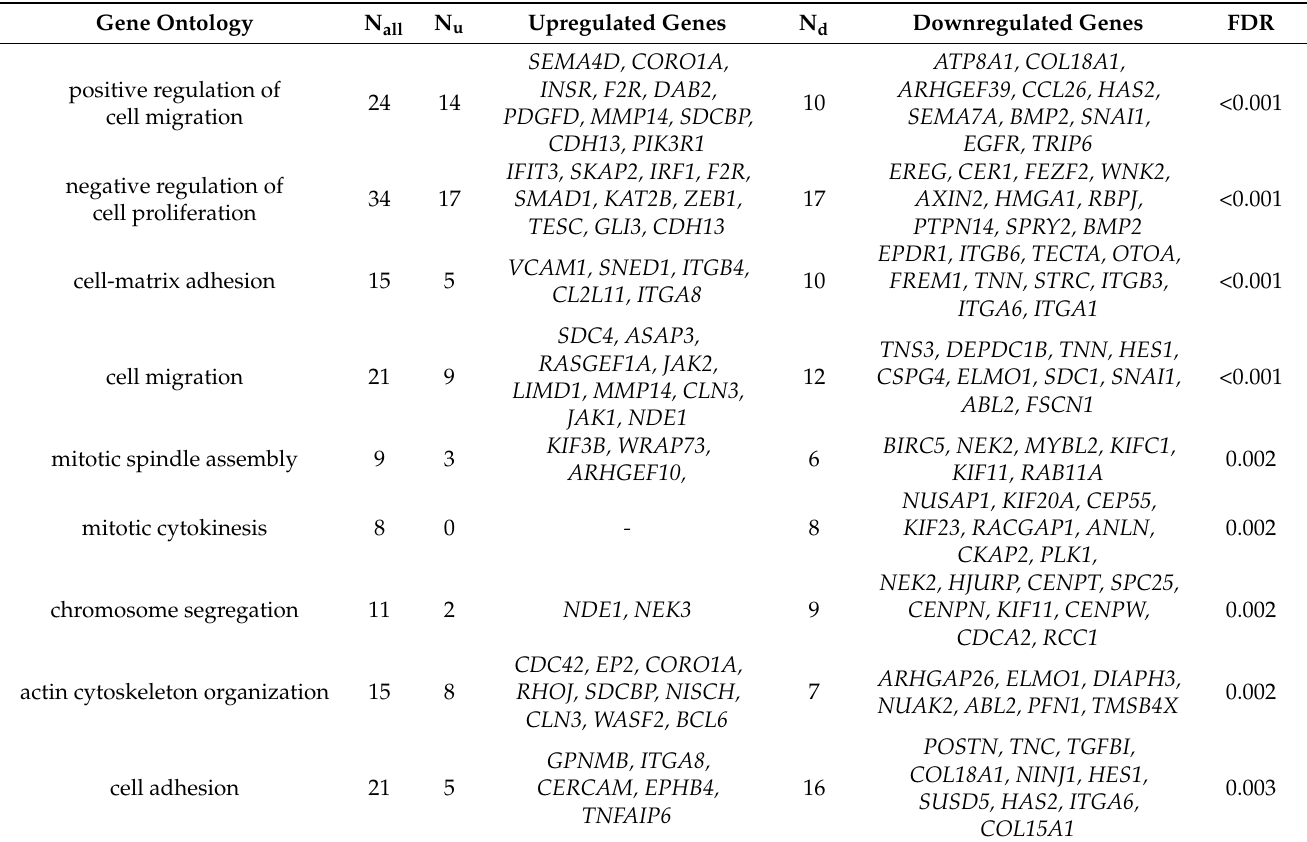
Table 1. The significant enrichment in Gene Ontology terms detected on the basis of comparative analysis of DEGs set between BPV-E4 and the control